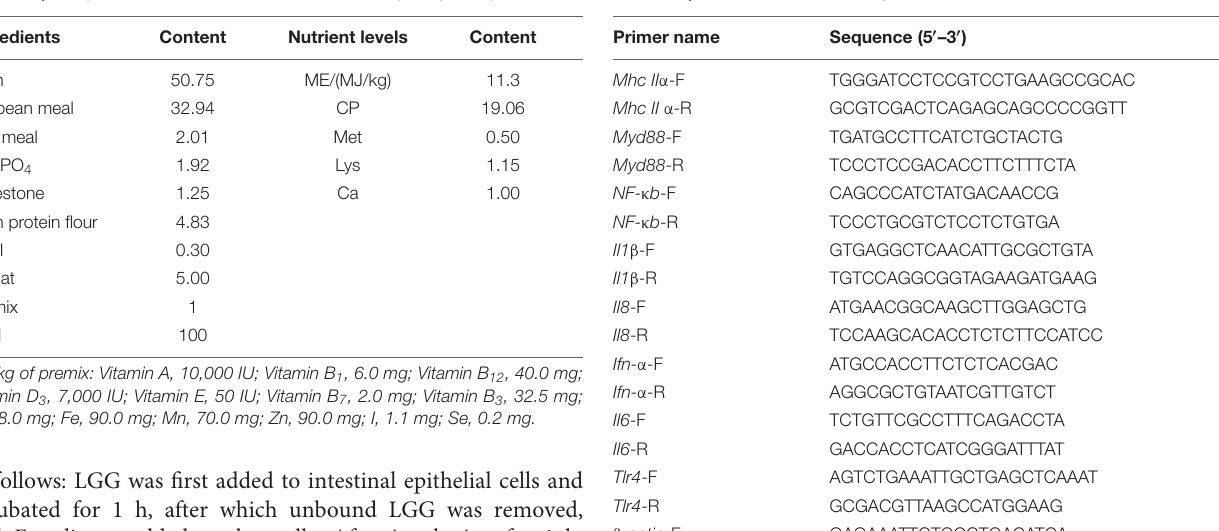
TABLE 2 | Primers used in this